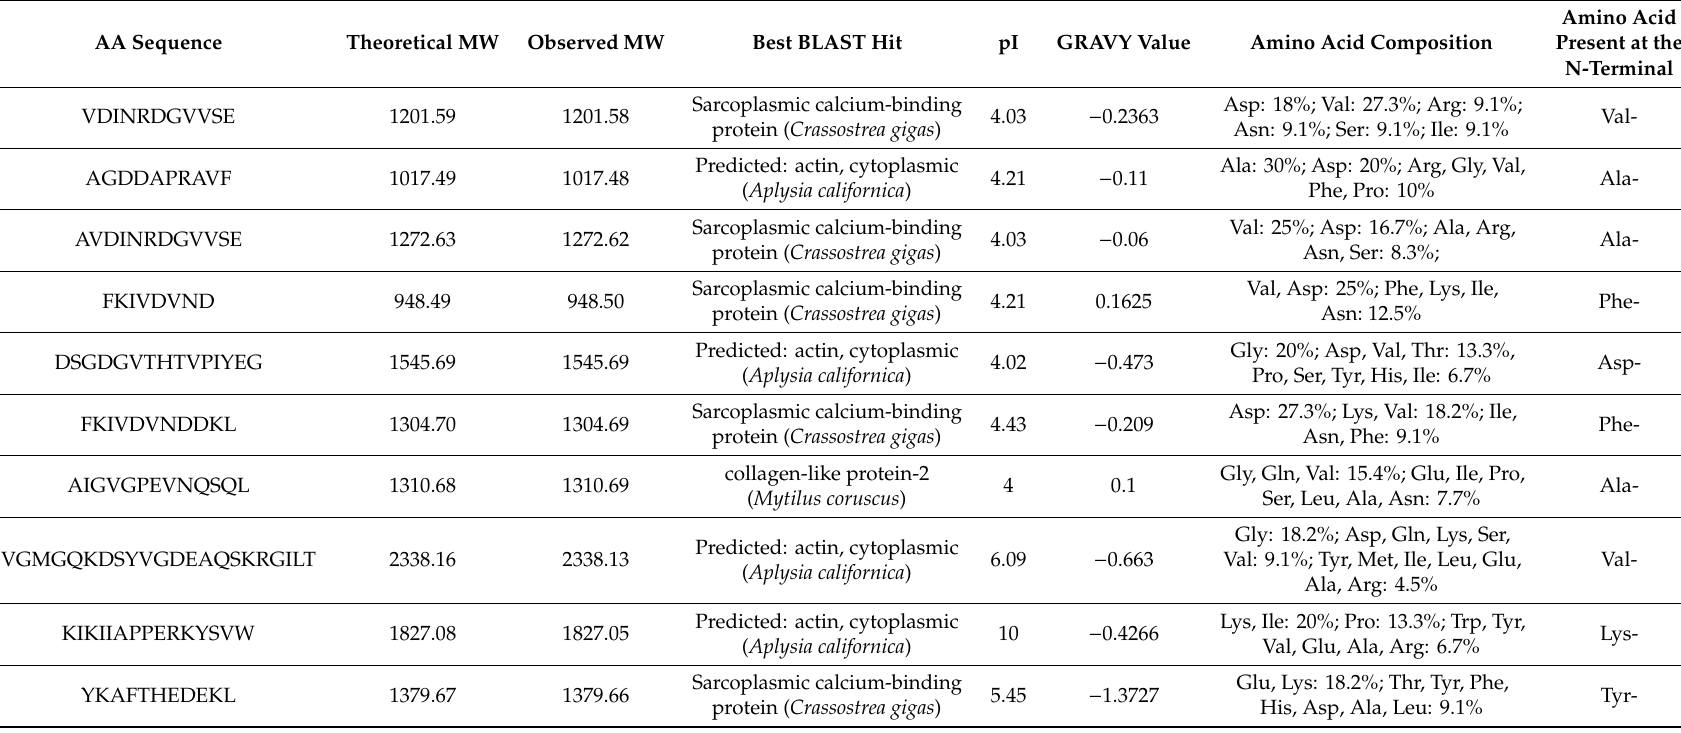
Table 2. Peptide sequence and other properties. AA: Amino Acid, MW: Molecular Weight, BLAST: Basic Local Alignment Search Tool, GRAVY: Grand Average of